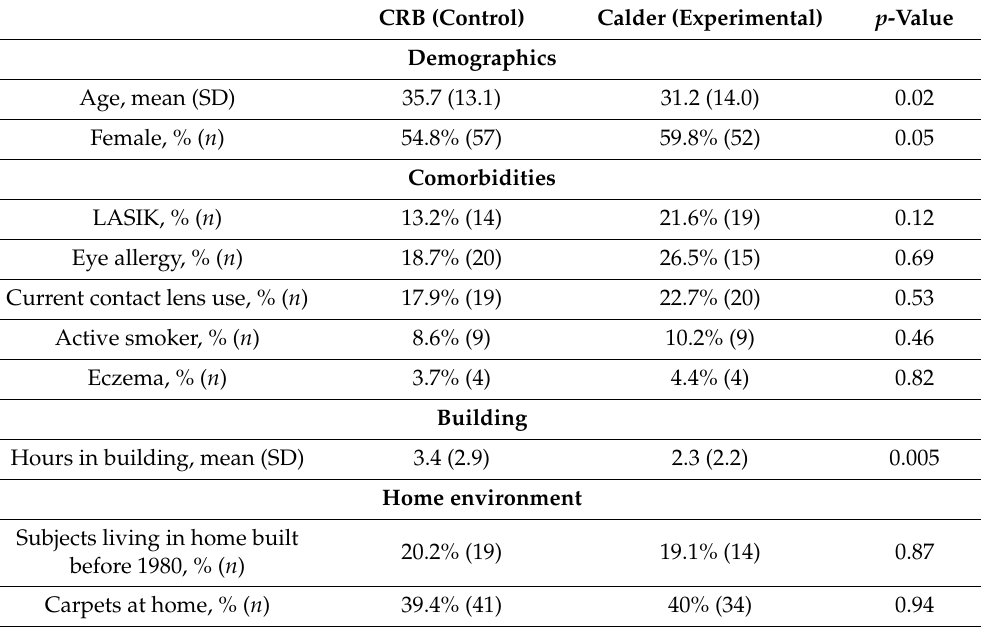
Table 1. Population sample composition by building.